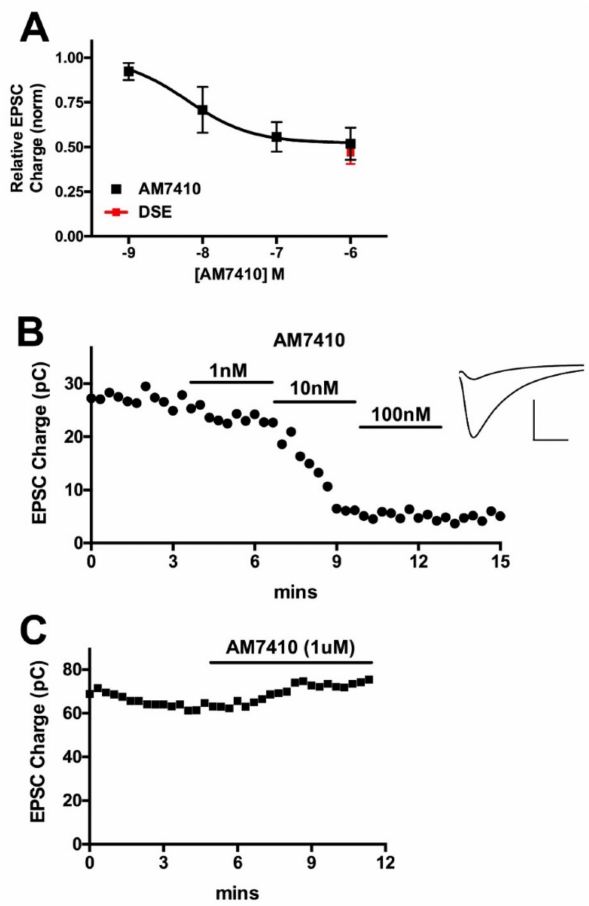
Figure 2. AM7410 is a potent and efficacious CB1 receptor agonist. ( A ) AM7410 inhibits excitatory neurotransmission in autaptic hippocampal neurons in a concentration-dependent manner. Maximal inhibition is similar to maximal inhibition from DSE in the same neurons; ( B ) Time course shows time course of inhibition of EPSCs after treatment with various concentrations of AM7410. Inset shows sample EPSCs before treatment and after treatment with 100 nM AM7410; ( C ) Sample time course shows absence of AM7410 effect in CB1 − / −